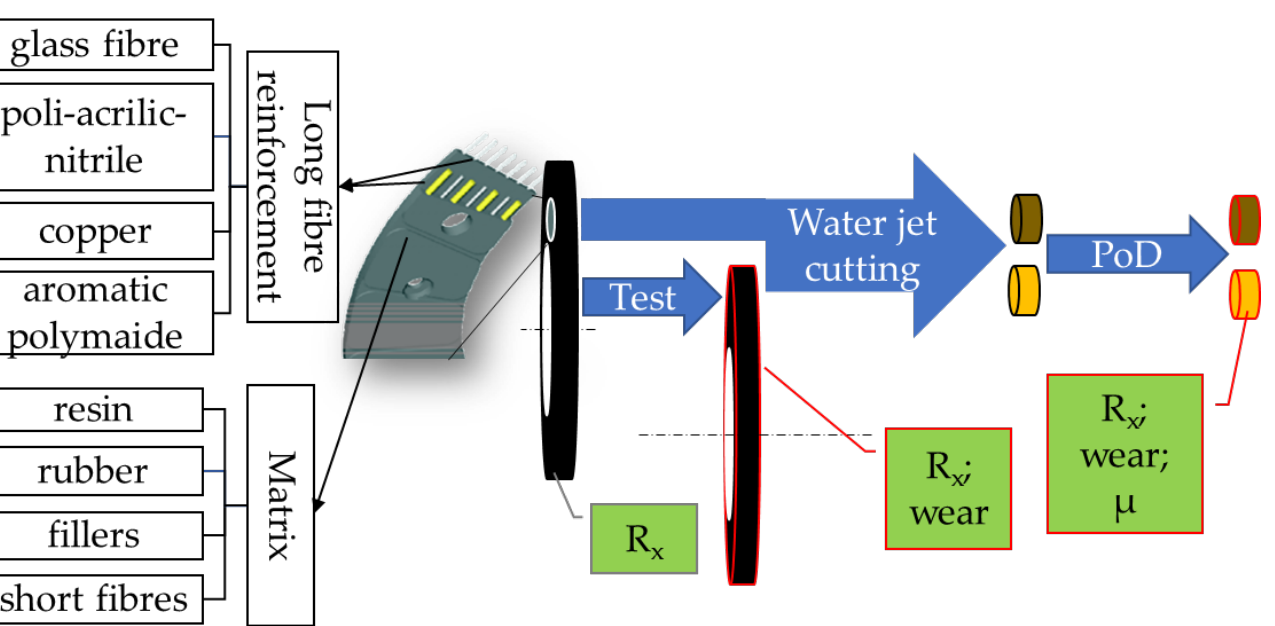
Figure 2. The hybrid composite material components and the tribological investigation process. where R x is R a , R z and R max